Question: Write a caption explaining this figure to a reader.
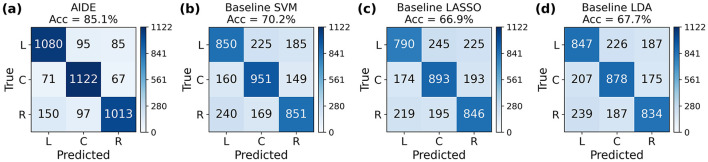
Answer: Balanced multi-class predictions in StratifiedKFold cross-validation. Raw-count confusion matrices aggregated over 10 seeds × k ∈ {3, 4} cross-validation folds. Each cell shows the number of trials of the true class (row) predicted as the column class. (a) AIDE, (b) baseline SVM, (c) baseline LASSO, (d) baseline LDA.